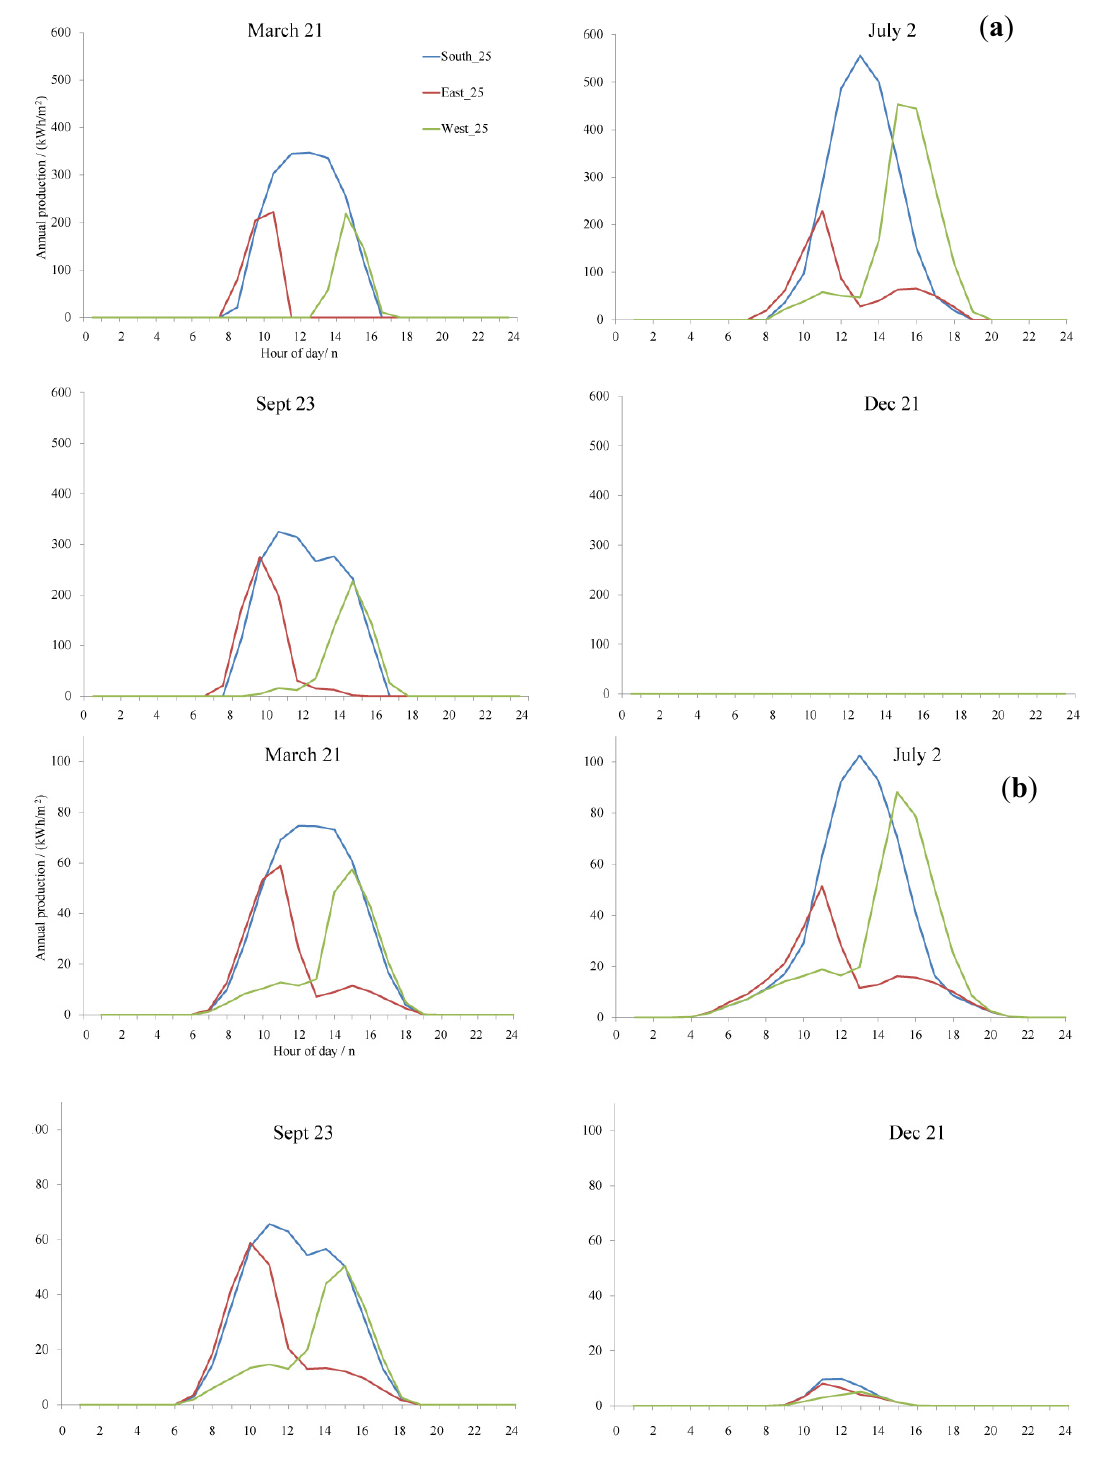
Figure 7. ( a ) Solar Thermal production (25 °C) during the four selected days; ( b ) PV production during the four selected